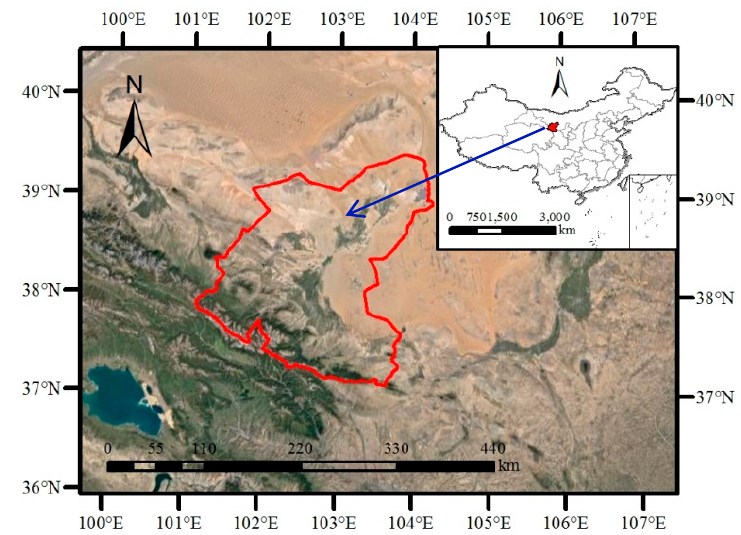
Figure 1. The geographic location of the Shiyang River Basin in China.